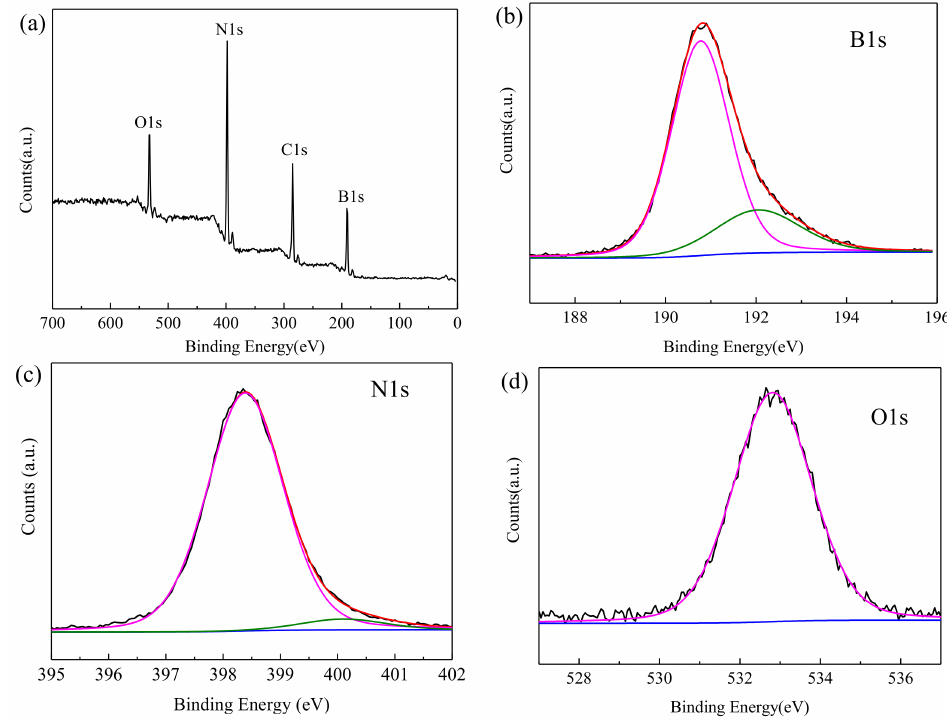
Figure 2. XPS spectra of the BN sample. ( a ) Survey spectrum; ( b ) B1 s ; ( c ) N1 s ; and ( d ) O1 s